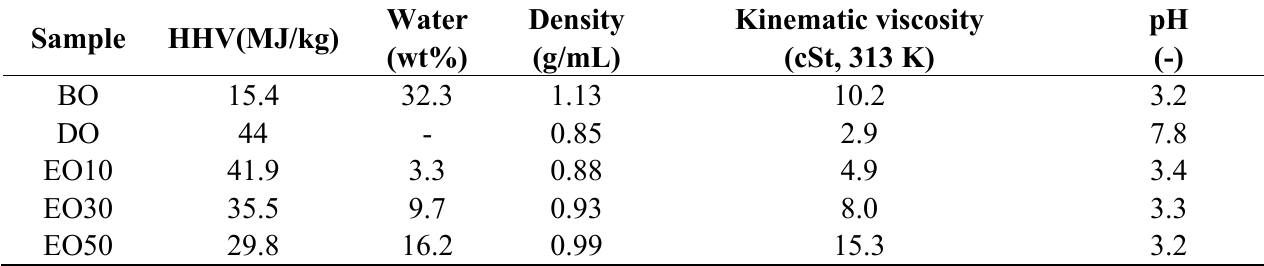
Table 2. Fuel properties of the BO, DO and their